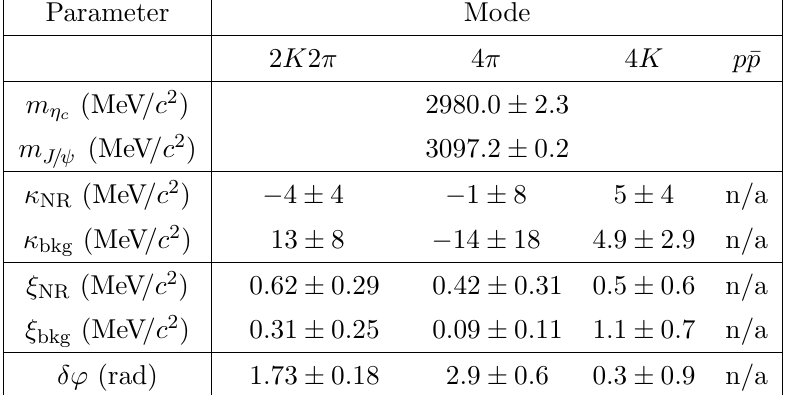
and c ! (cid:17) c (cid:30) ) is reported s